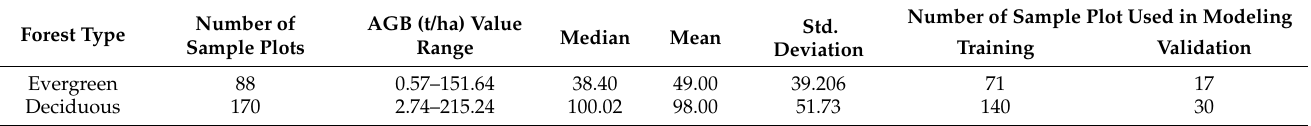
Table 4. Descriptive statistics of the field-measured AGB (t/ha) for the two forest